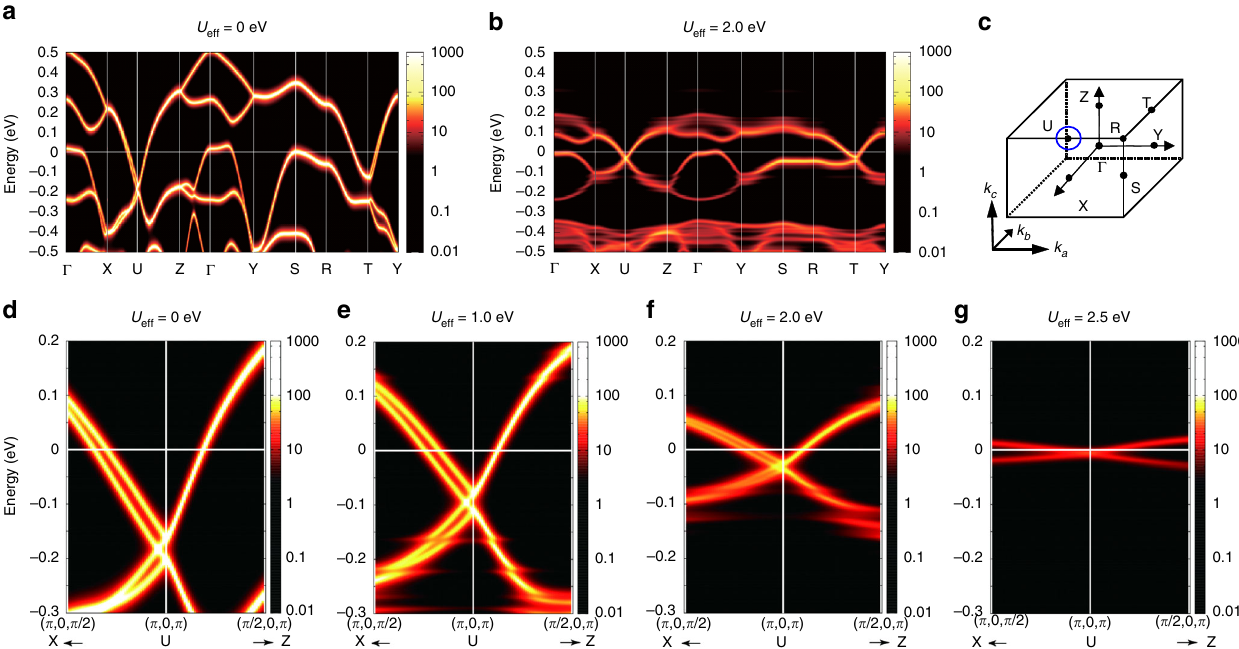
Fig. 3 Band structure calculated by density functional theory and dynamical mean fi eld theory. a , b Overview of band structure with the Hubbard U eff = 0 and 2.0 eV. The scale bar denotes the magnitude of spectral function. c Illustration of momentum space and position of Dirac line node (blue line). d – g The magni fi ed view of band structure around the Dirac line node with different U eff . The Dirac line node approaches the Fermi energy with increasing U eff . The Dirac-like dispersion is signi fi cantly renormalized for U eff = 2.5 eV, which is a precursory phenomenon of the Mott criticality. The averaged Fermi velocity is 2.0 × 10 5 , 1.8 × 10 5 , 8.1 × 10 4 , and 2.0 × 10 4 m s − 1 at U eff = 0, 1.0, 2.0, and 2.5 eV,